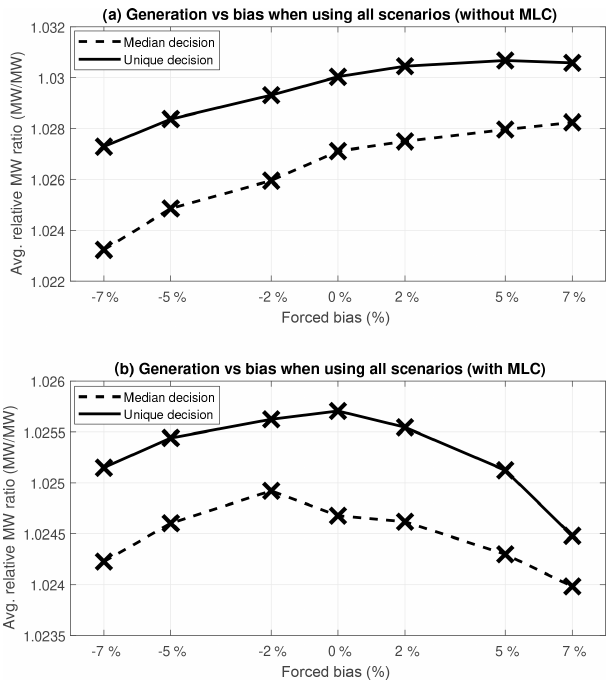
Figure 7. Average power generation using median decision and unique decision optimization algorithms as a function of bias with- out (a) and with (b)